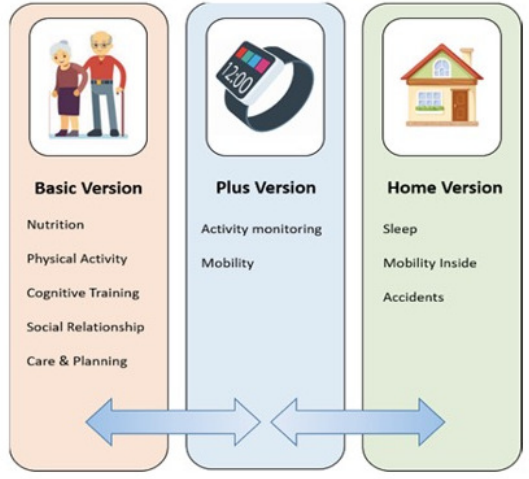
Figure 4. The solution proposed in [26] for activity monitoring in multiple domains of preventive measures: nutritional guidance, physical exercise promotion, cognitive practice, social activity, and positive care